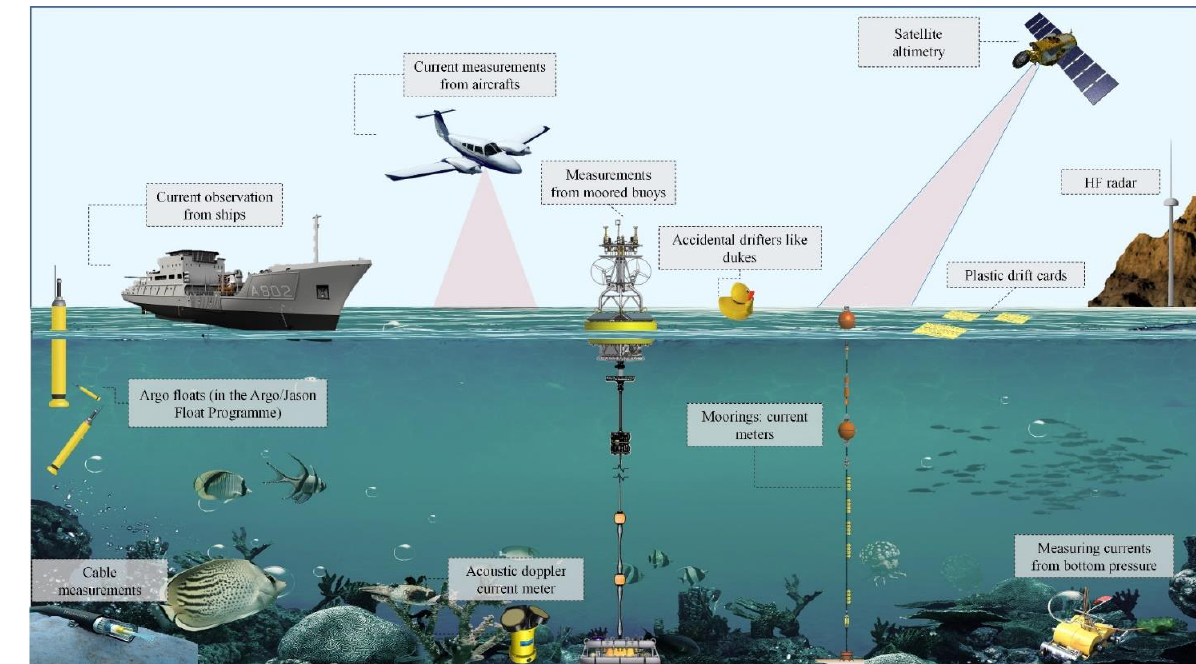
Figure 4. Different methods for ocean current estimation. Table 2. Different RS systems for OSC estimation along with their advantages and limitations.